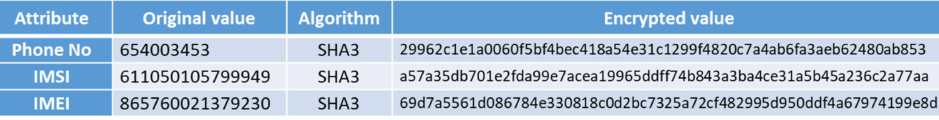
Figure 4. An example of the input and output after running anonymization.